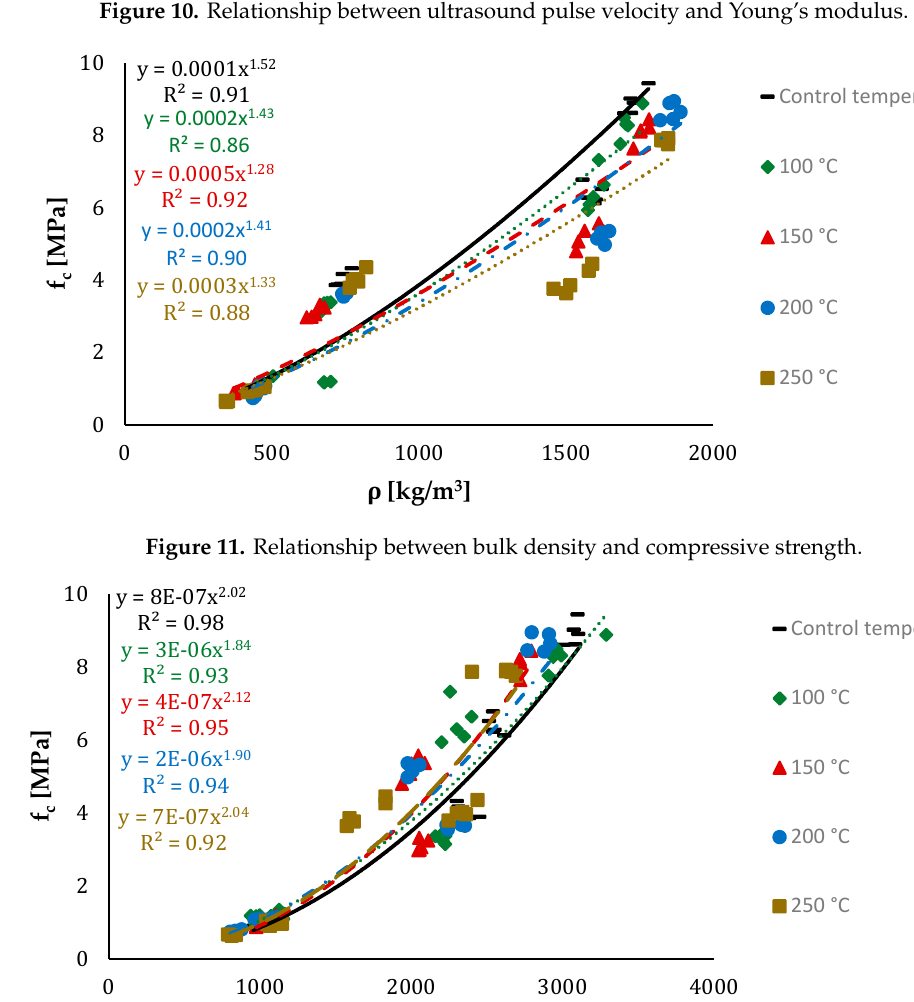
Figure 11. Relationship between bulk density and compressive strength.